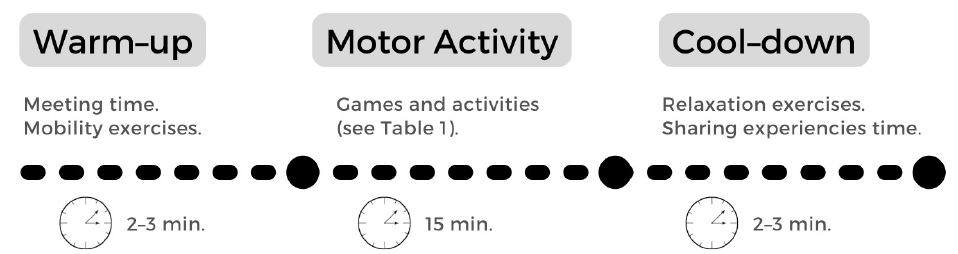
Figure 1. Schematic representation of a session day.